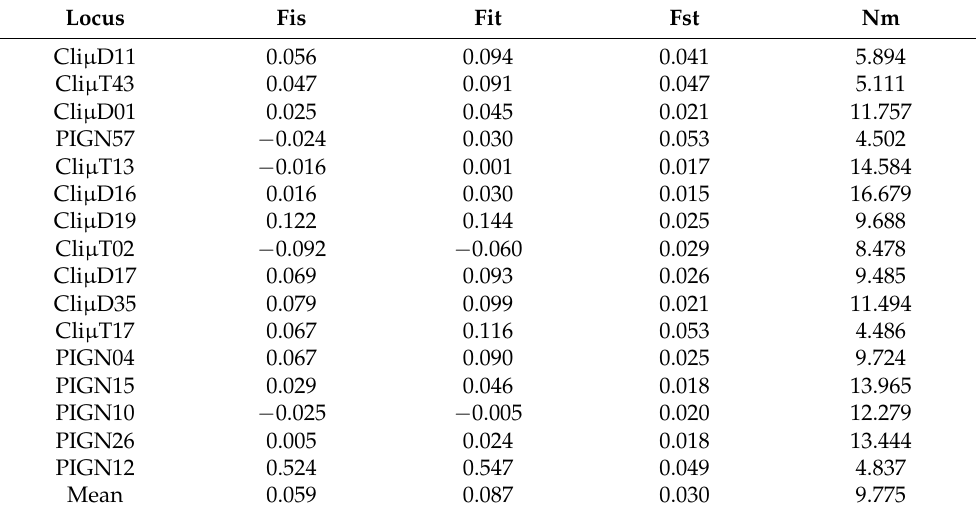
Table 4. F-statistics and estimates of Nm coefficients across 17 microsatellite